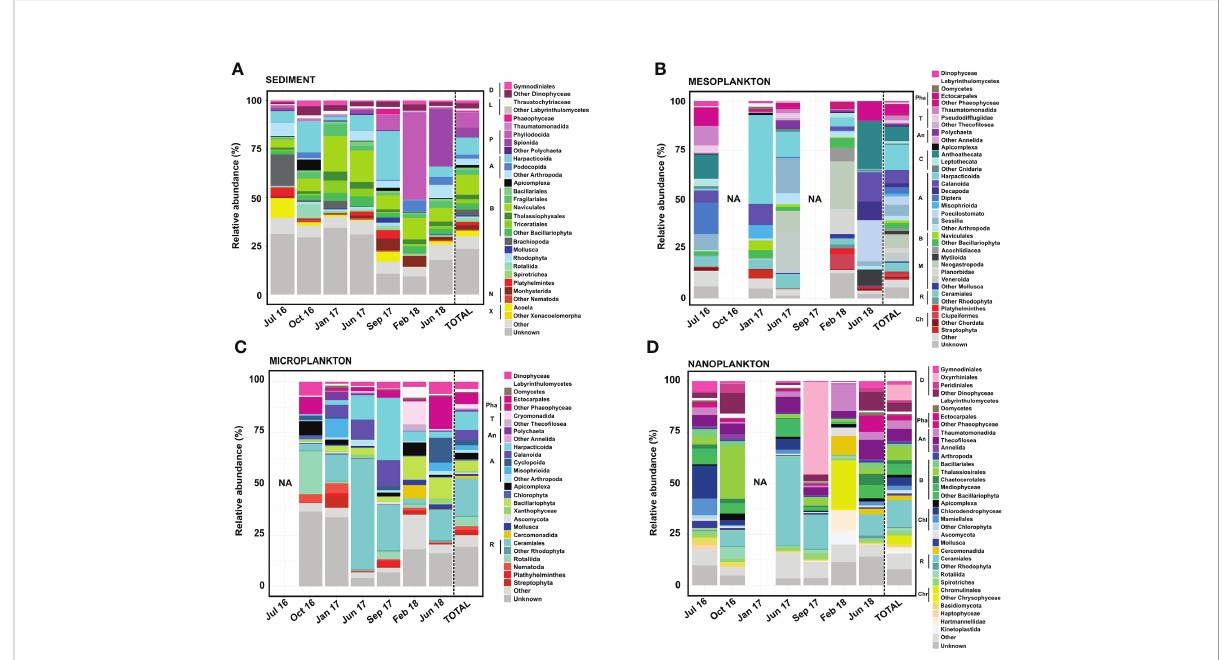
FIGURE 5 Eukaryote composition in terms of relative abundance obtained from (A) sediment, (B) mesoplankton, (C) microplankton, and (D) nanoplankton. Legend: A, Arthropoda; An, Annelida; B, Bacillariophyta; C, Cnidaria; Ch, Chordata; Chl, Chlorophyta; Chr, Chrysophyceae; D, Dinophyceae; L,